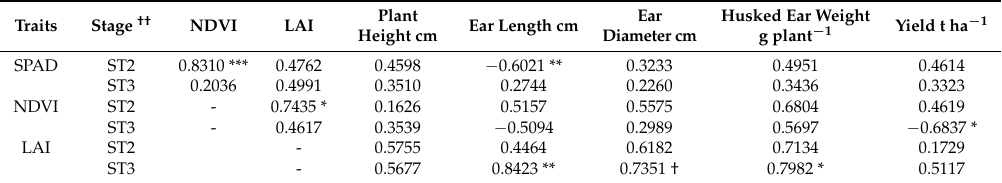
Table 3. Correlation coefficients ( r ) between the spectral traits, LAI and yield of sweet corn under unirrigated (I 0 )